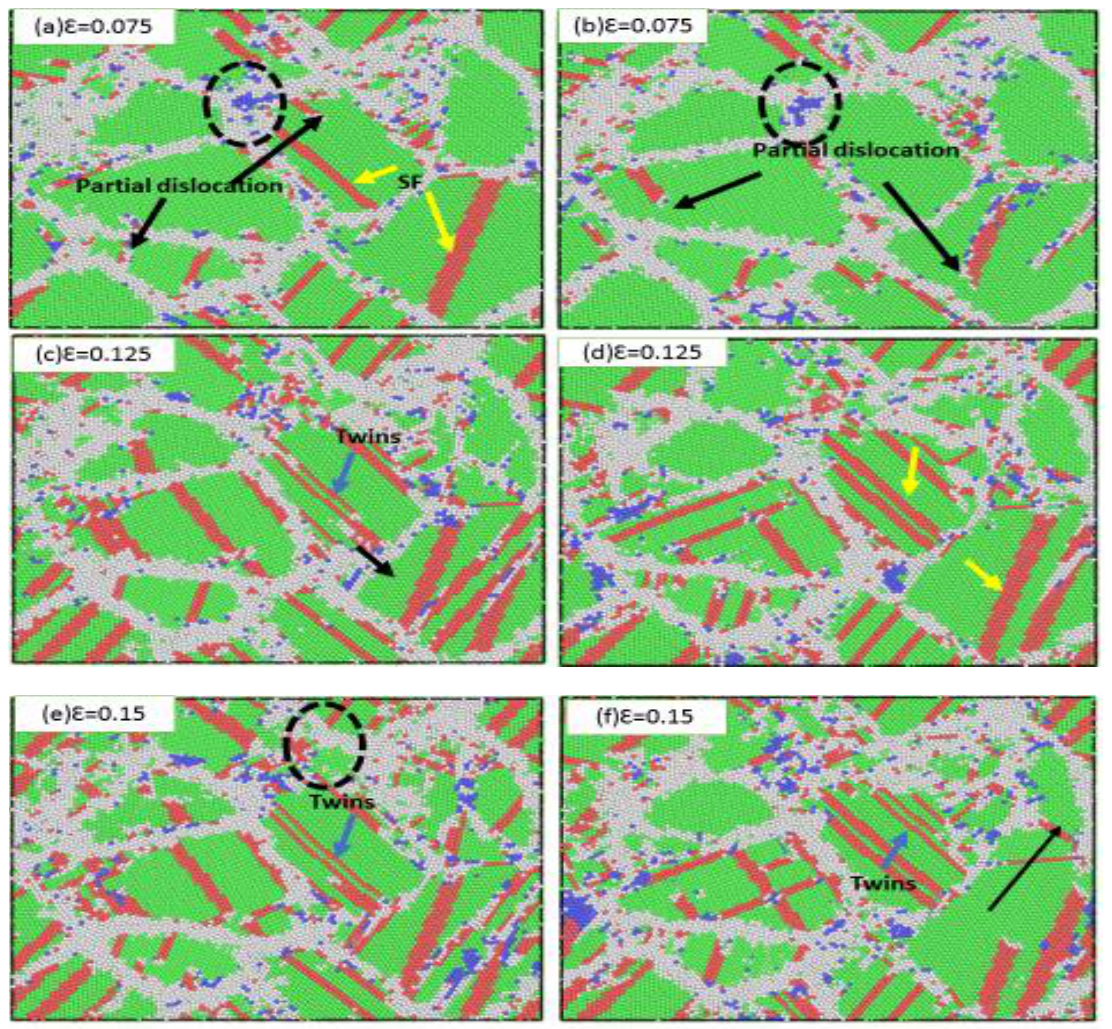
Figure 5. Snapshots of the simulated stainless-steel with a mean grain size of 3.6 nm, deformed at strain rates of ( a , c , e ) 6 × 10 9 s − 1 and ( b , d , f ) 1 × 10 10 s − 1 . ( a , b ) present 0.075 true strain; ( c , d ) present 0.125 true strain; ( e , f ) present 0.15 true strain. Black arrows in ( a , b ) indicate partial dislocation. Yellow arrows in ( a , d ) indicate the stacking fault, while blue arrows indicate deformation twins.